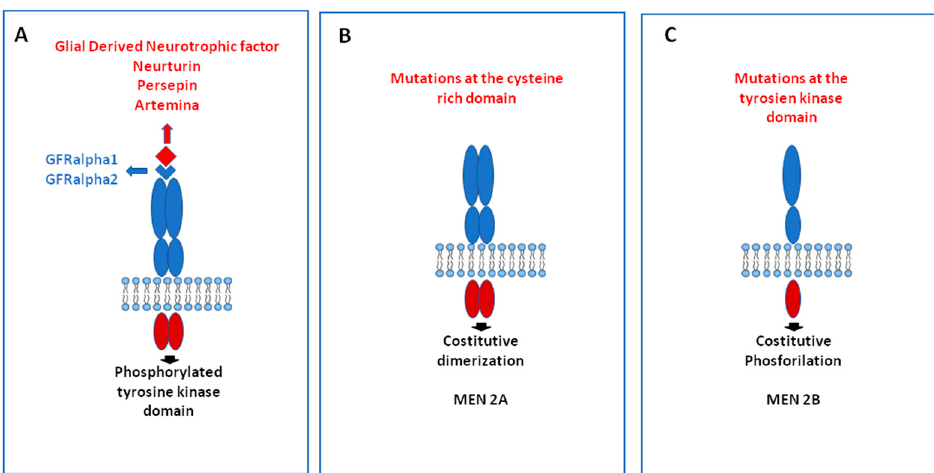
Figure 6. Mechanisms of activation of the RET gene: in physiological conditions, the binding of a RET ligand, which is mediated by a co-receptor, induces the dimerization of two to RET molecules, causing the phosphorylation of the tyrosine kinase domain ( A ). When a point mutation in the cysteine domain is present, as it happens in multiple endocrine neoplasia (MEN) type 2A syndrome, the constitutive dimerization of 2 RET molecules occurs, and the receptor is activated independently by ligand-binding ( B ). Alternatively, if the mutation occurs in the tyrosine kinase domain, as it happens in MEN 2B syndrome, constitutive phosphorylation activates the RET receptor independently by ligand-binding ( C ).